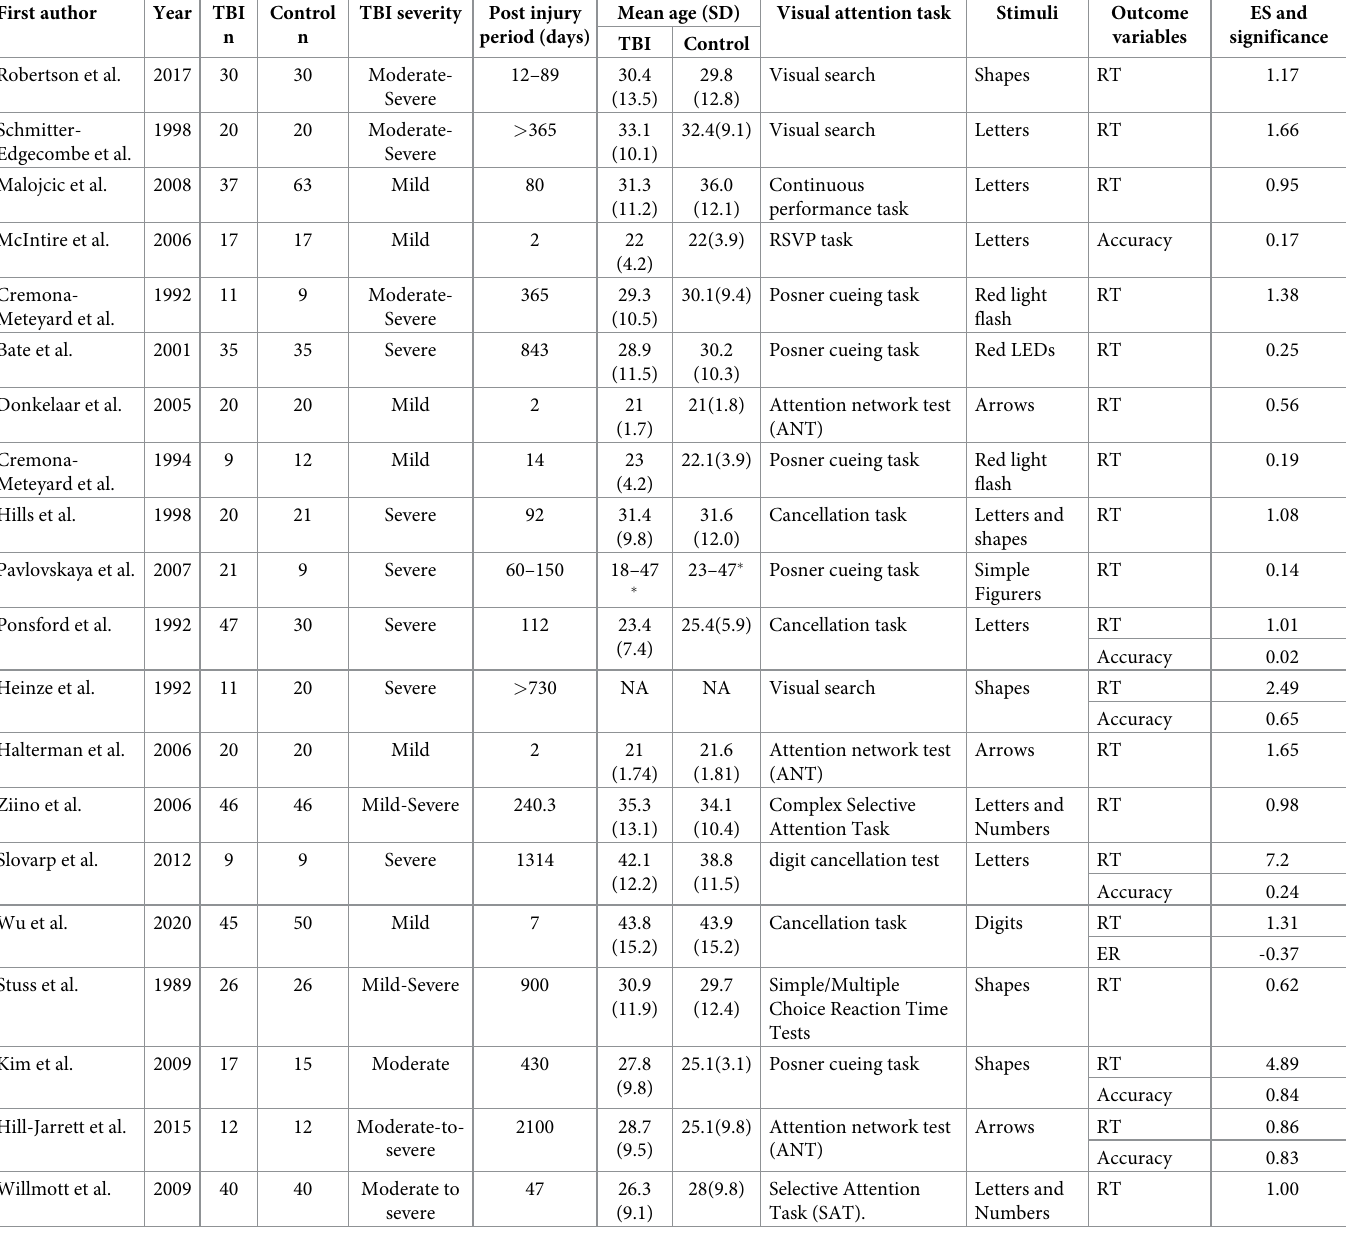
Table 3. Participant summary, task characteristics, and results for the 20 reported